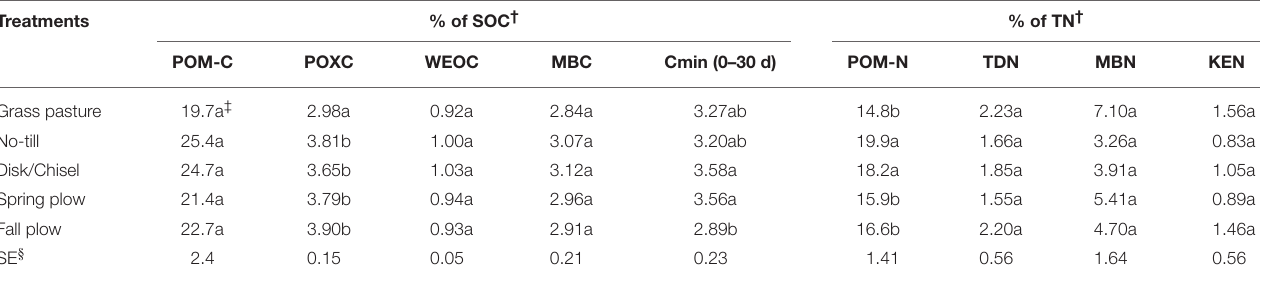
TABLE 4 | Proportions of SOM pools in soil organic carbon (SOC) and total nitrogen (TN) in treatments at surface 0- to 15-cm Walla Walla silt loam near Pendleton, Oregon. Treatments % of SOC † % of TN † POM-C POXC WEOC MBC Cmin (0–30 d)